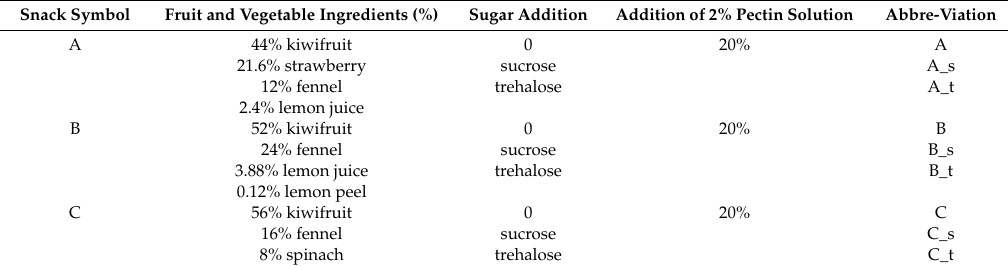
Table 1. Composition of snacks based on yellow kiwifruit, containing 80% fruit and vegetable puree and 20% pectin